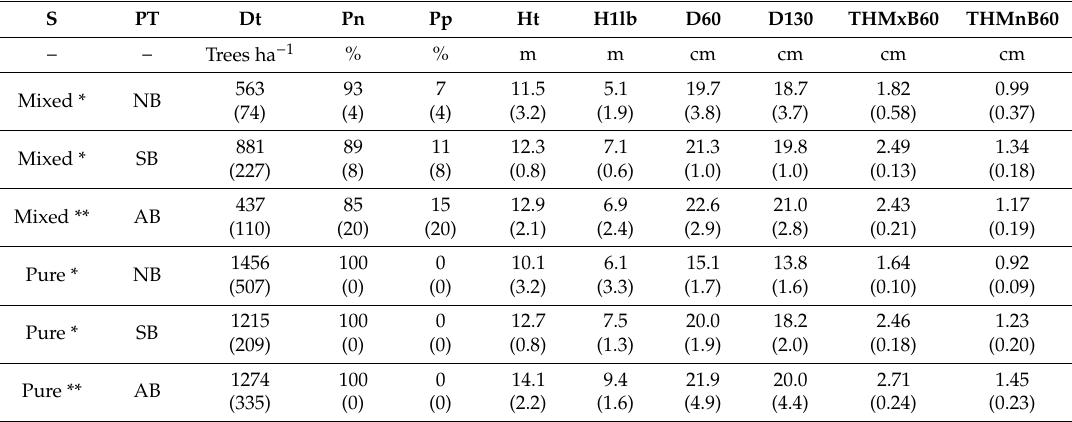
Table 2. Characteristics of no burning (NB), spring burning (SB), and autumn burning (AB) plots in mixed and pure stands (mean and standard